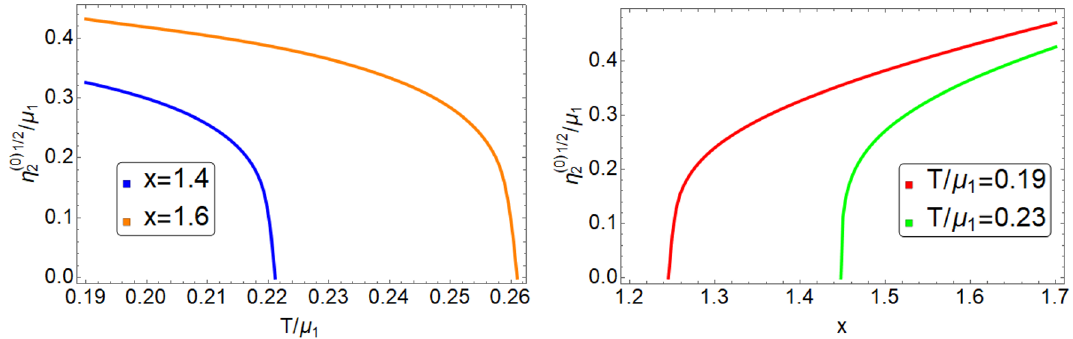
of uniform SC as the function of temperature T (left) and 2